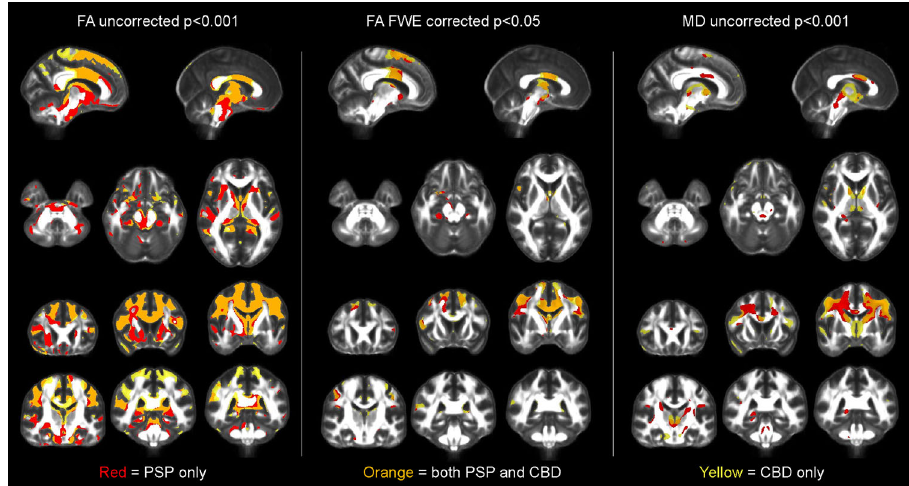
Fig. 4 Diffusion tensor imaging fi ndings at baseline. The left two panels show regions with decreased fractional anisotropy (FA) compared to controls, either uncorrected for multiple comparisons at p < 0.001 (left) or after correction for multiple comparisons using family-wise error (FWE) correction at p < 0.05 (middle). The right panel shows regions with increased mean diffusivity (MD) compared to controls shown uncorrected at p < 0.001. Results for progressive apraxia of speech patients with progressive supranuclear palsy (PSP) are shown in red, results for progressive apraxia of speech patients with corticobasal degeneration (CBD) are shown in yellow, and regions of overlap between the two groups are shown in orange. Statistical comparisons were performed using two-sided t-tests in